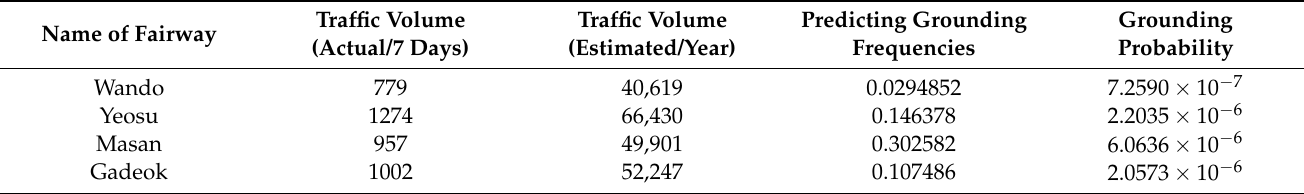
Table 9. Probability of grounding by